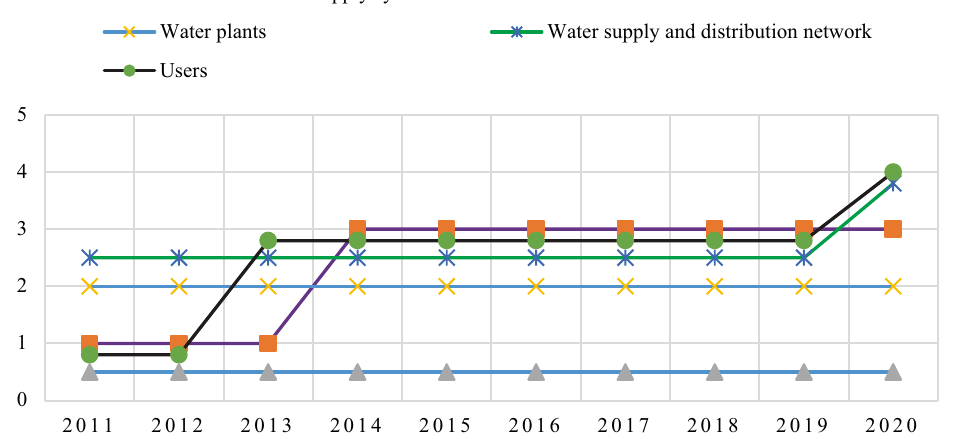
Figure 9. Trends in cloud assessment levels of resilience capacity.